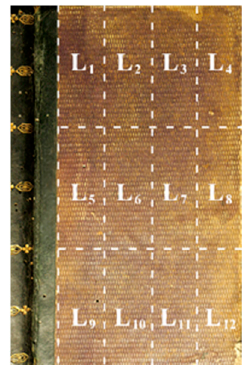
Figure 1. The book front cover. It was ideally divided into twelve, L 1 – L 12 , sections (white grid lines) for performing nuclear magnetic resonance (NMR) measurements and linked to infrared thermography (IRT) inspections.